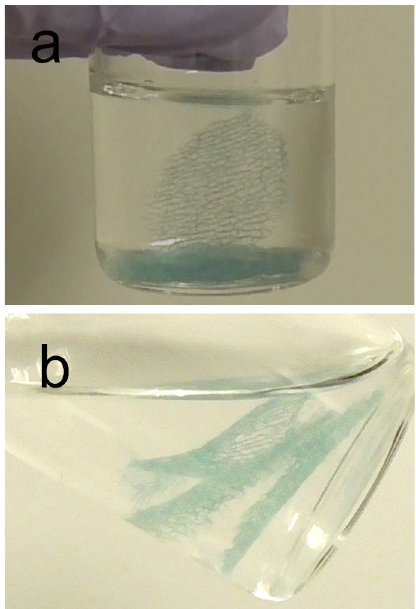
Figure 3. ( a ) The first layer is dissolved. The first PGA sheet is released into the artificial gastric juice during slow shaking. ( b ) All three layers have dissolved, and three PGA sheets are floating in the artificial gastric juice. PGA, polyglycolic acid